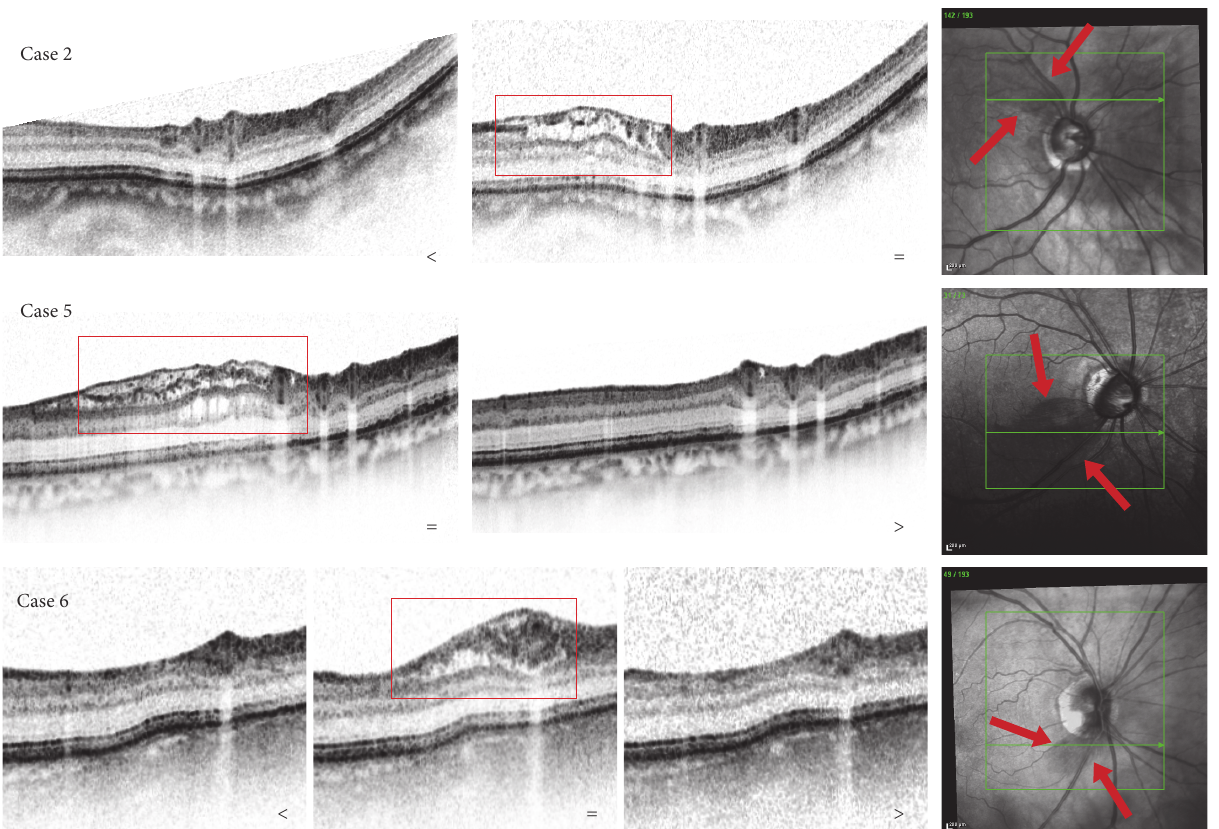
Figure 1: IR (right) and SD-OCT images of 3 cases, representing cases with measurements before ( < ) and during (=) the retinoschisis (Case2) and representing cases with measurements during and after ( > ) the retinoschisis (Case5). Case6 was the only case imaged before ( < ), during (=), and after ( > ) the presence of the retinoschisis. The detail inside the red boxes represents the retinoschisis. Between the red arrows in the IR fundus images is the area of the focal retinoschisis. IR: infrared image; SD-OCT: spectral domain optical coherence